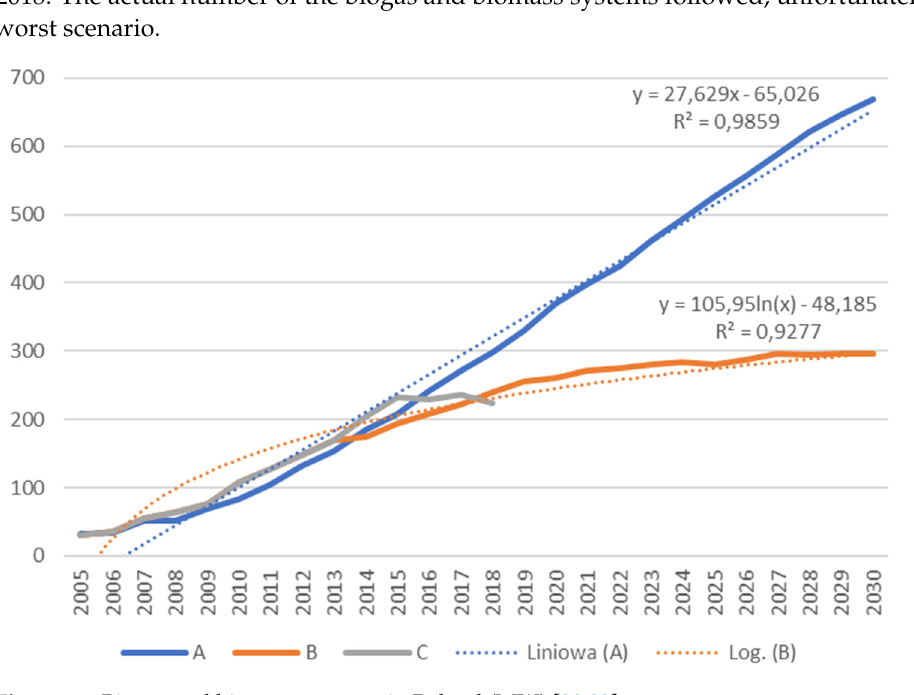
Figure 10. Biogas and biomass systems in Poland (MW) [28,82].